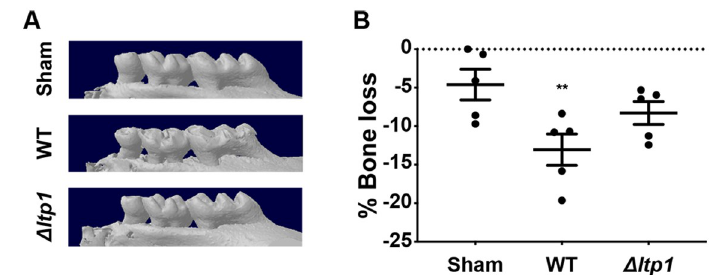
Fig 9. Alveolar bone loss in mice following infection with P . gingivalis WT or Δ ltp1 mutant was determined by μ CT analysis. A) Representative images of the maxillary molars reconstructed with NRecon Reconstruction software. B) Reconstructed images were analyzed along the sagittal slice to determine the distance between the ABC (alveolar bone crest) and the CEJ (cementoenamel junction) relative to the root length of the tooth. The data are the averages and scatter for each mouse from 12 measurements across both the first and second molars relative to the sham-treated mice and are expressed as means ± SE. �� p < 0.01 by one-way analysis of variance relative to sham infection.